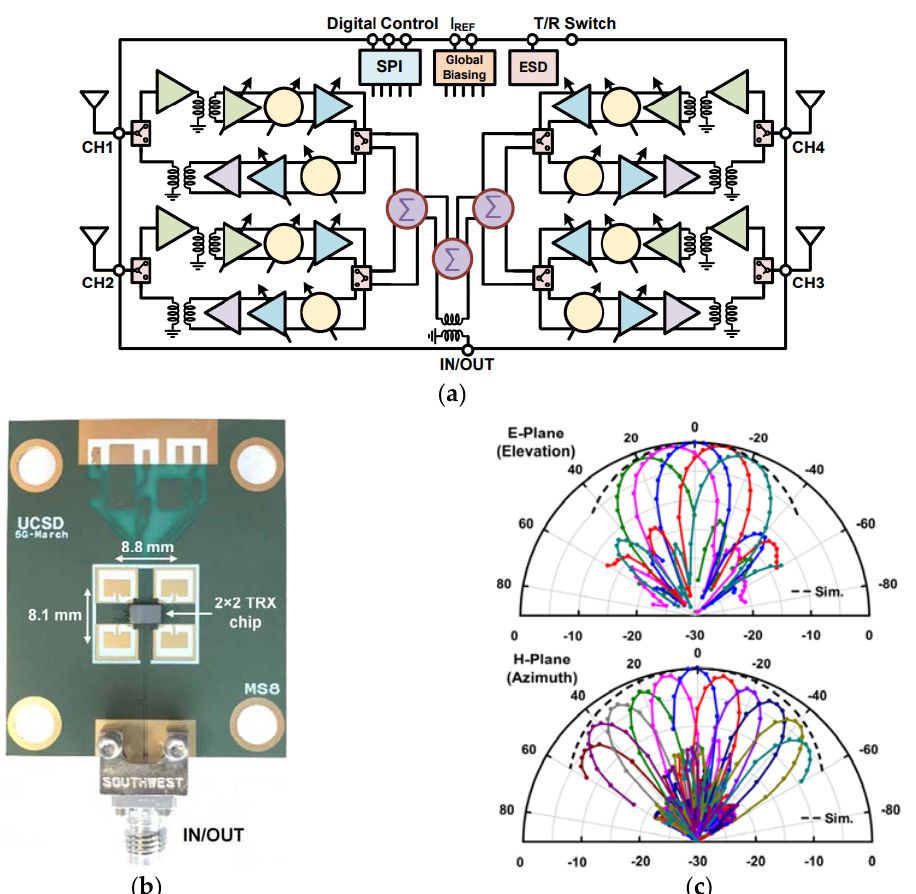
Figure 20. ( a ) Block diagram of 2 × 2 transmit/receive 5G phased array. ( b ) Photograph of the flip ‐ chip test board with 2 × 2 transmit/receive 5G phased array. ( c ) Measured E and H ‐ plane patterns of 4 × 8 transmit/receive 5G phased array in Rx mode (Redrawn from [54,60]).